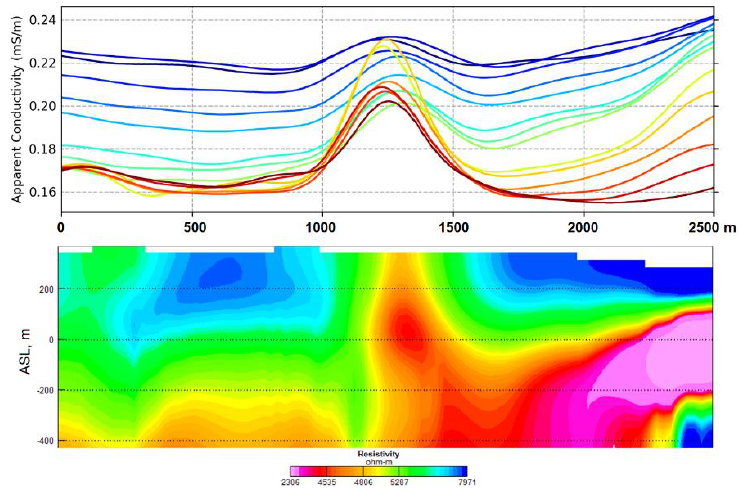
Figure 8. MobileMT apparent conductivity profiles ( top ) along the line that transects KL − 22 kim- berlite pipe. The frequency range from 80 Hz (blue) to 13,571 Hz (pink); resistivity-depth inverted section ( bottom ).